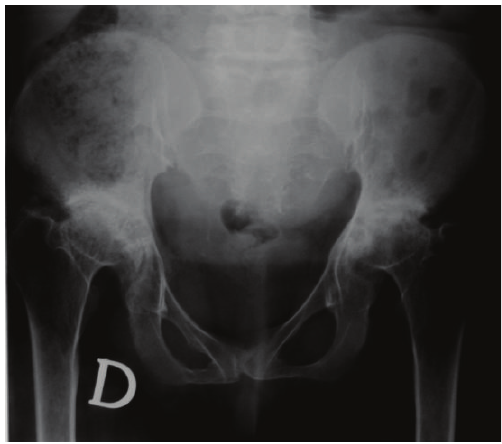
Figure 3: Standing anteroposterior XR view of the pelvis showing short femoral necks and severe degenerative changes of the hip joints.